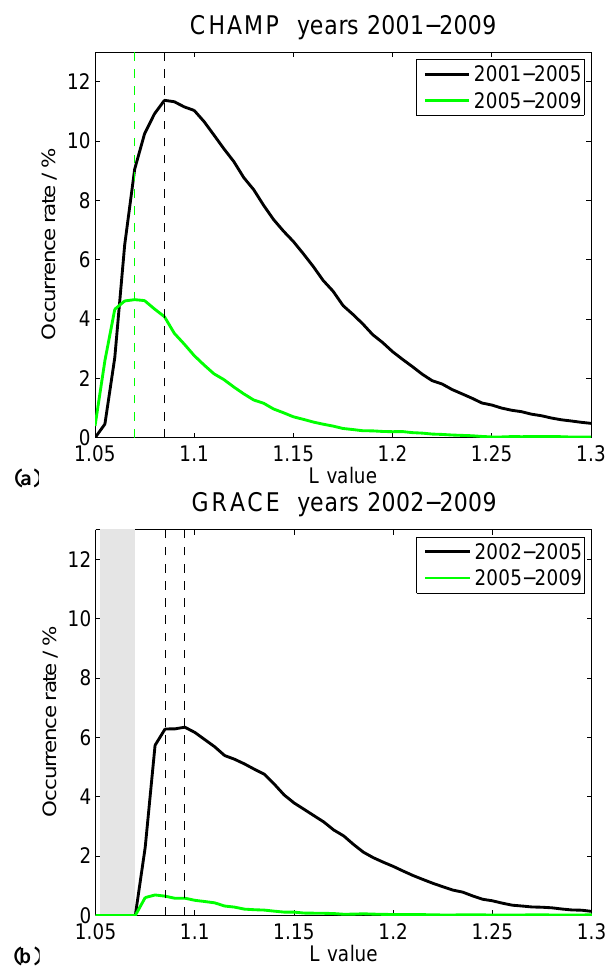
Fig. 10. Occurrence rate of EPBs versus L-value of fluxtube based on CHAMP PLP (top) and GRACE KBR (bottom) observations. The shaded area in the bottom panel represents the range of L-value not sampled by